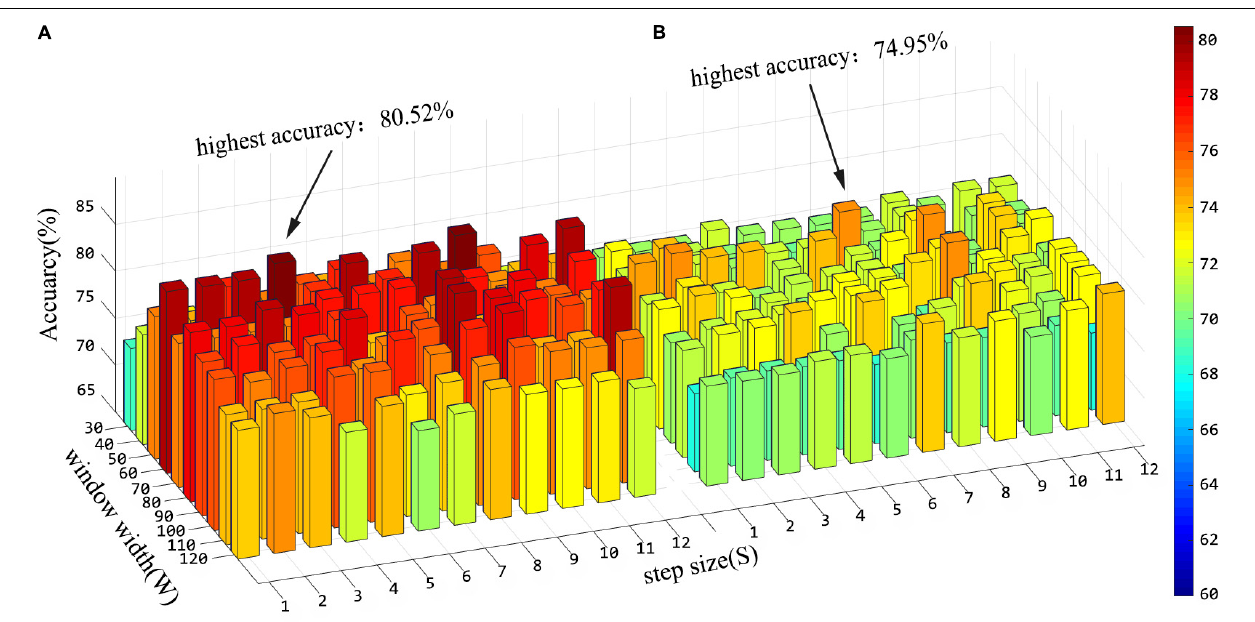
FIGURE 6 | Histogram of classification accuracy of the “hierarchical sub-network method” (A) and the “fully-network FCN method” (B) under various sliding window parameters.